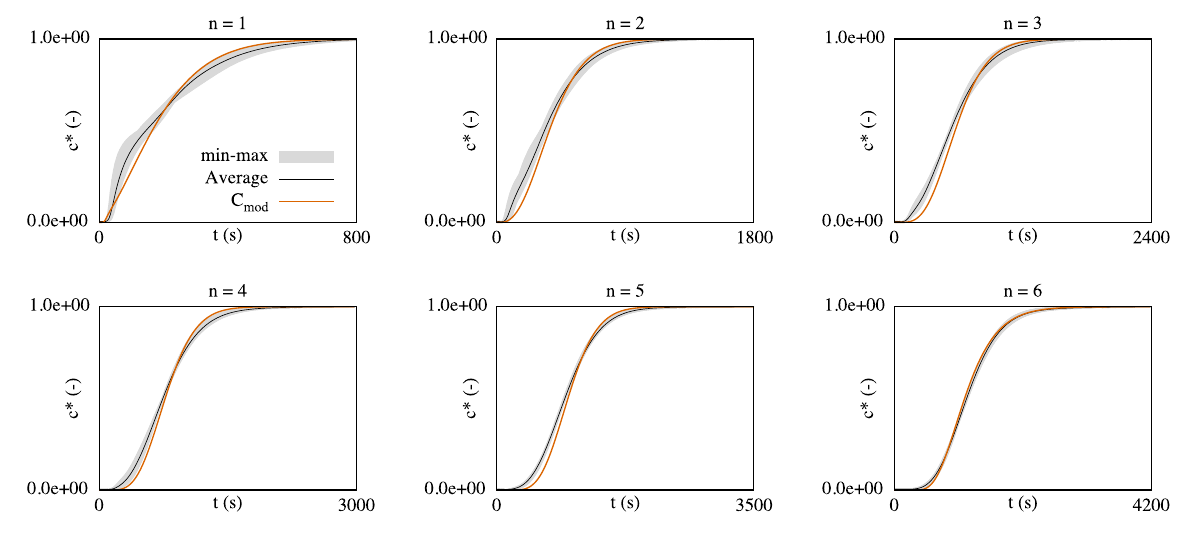
Figure 4. Modelling Results obtained with the classical Advection-Dispersion